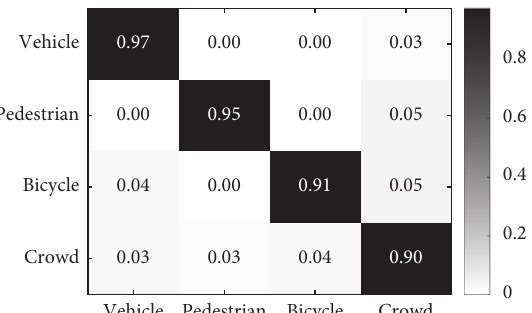
Figure 7: Confusion matrix of recognition results based on SVM- BDT